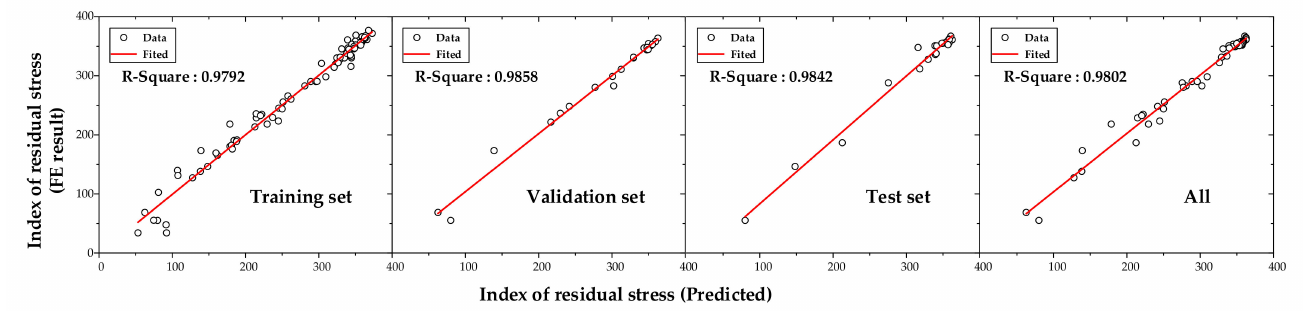
Figure 11. Comparison of the index of residual stress between the FE result and the DNN.